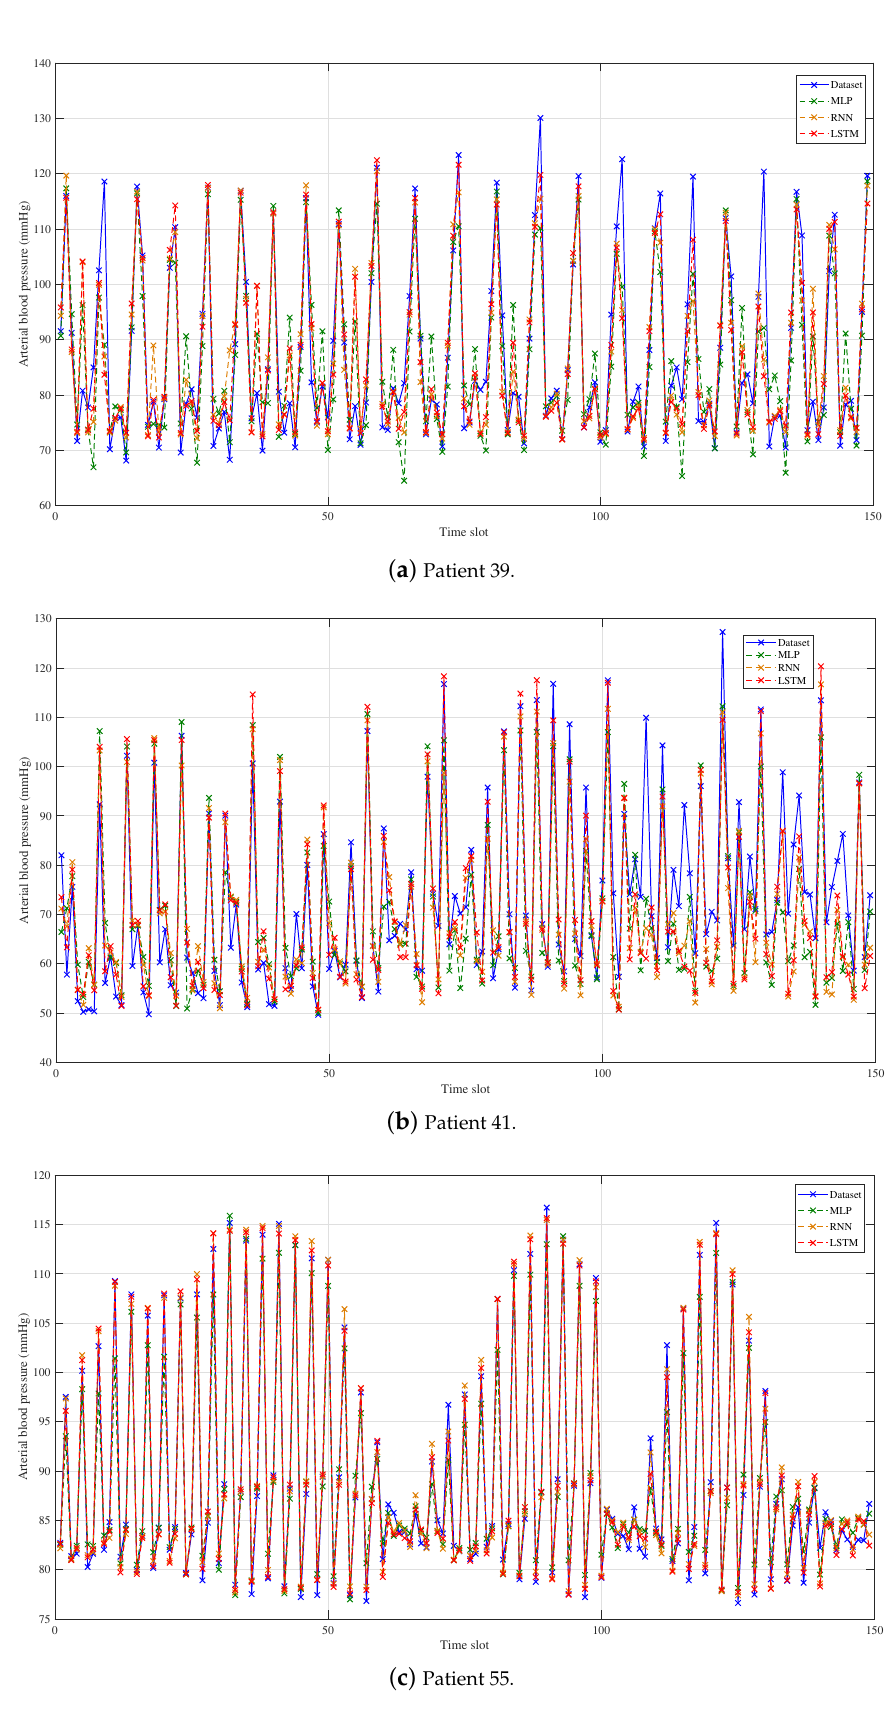
Figure 3. Prediction results of group 1: MLP, RNN, and